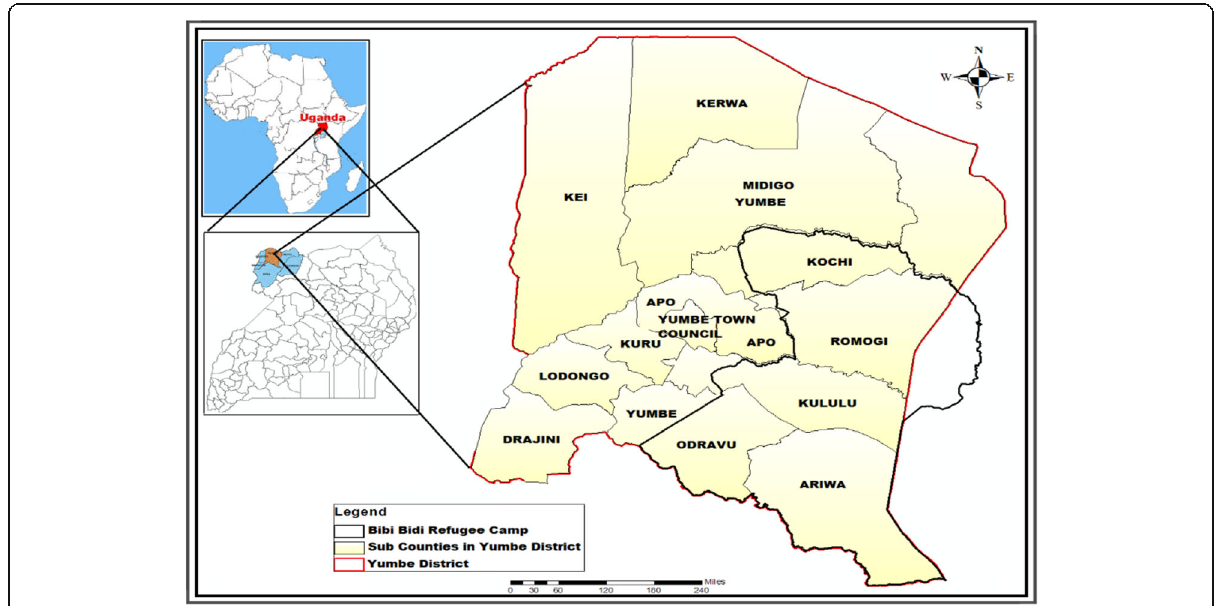
Fig. 1 Map of Uganda showing the location of Bidibidi